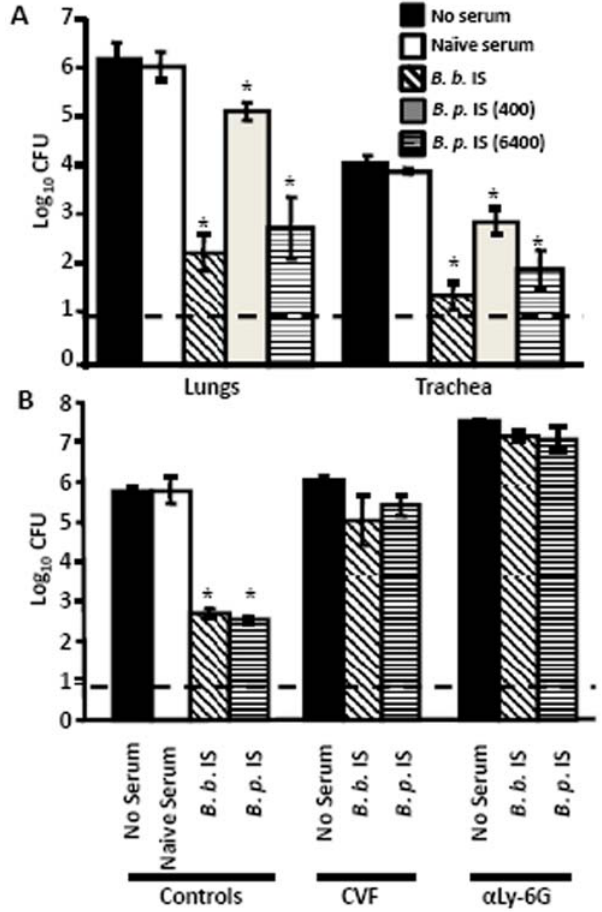
Figure 3. Effect of Complement and Neutrophils on B.pertussis serum antibody-mediated clearance of B.bronchiseptica . (A) Wild type mice infected with B. bronchiseptica were untreated (black bars) or i.p. injected with naı¨ve serum (white bars), B. bronchiseptica -immune serum (hatched bars), B. pertussis -immune serum titer 400 (gray bars), or B. pertussis -immune serum titer 6400 (horizontal lined bars) and then dissected Day 3 post-inoculation. (B) Wild type mice were complement (CVF) or neutrophil ( a Ly-6G) depleted, then inoculated with B. bronchiseptica , i.p. injected with the indicated serum and then dissected on Day 2 post-inoculation. B.b . indicates B. bronchiseptica -immune serum; B.p . indicates B. pertussis -immune serum titer 6400. Bacterial numbers are represented as the mean Log 10 CFU + / 2 SEM. Dashed line indicates the lower limit of detection. * indicates P value of , 0.05.